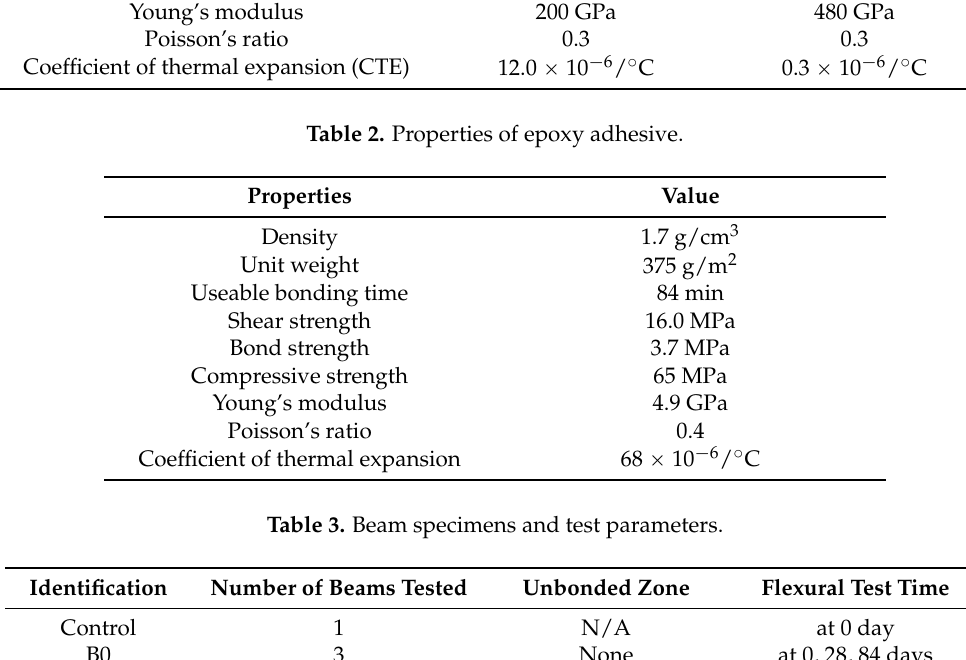
Table 3. Beam specimens and test parameters.